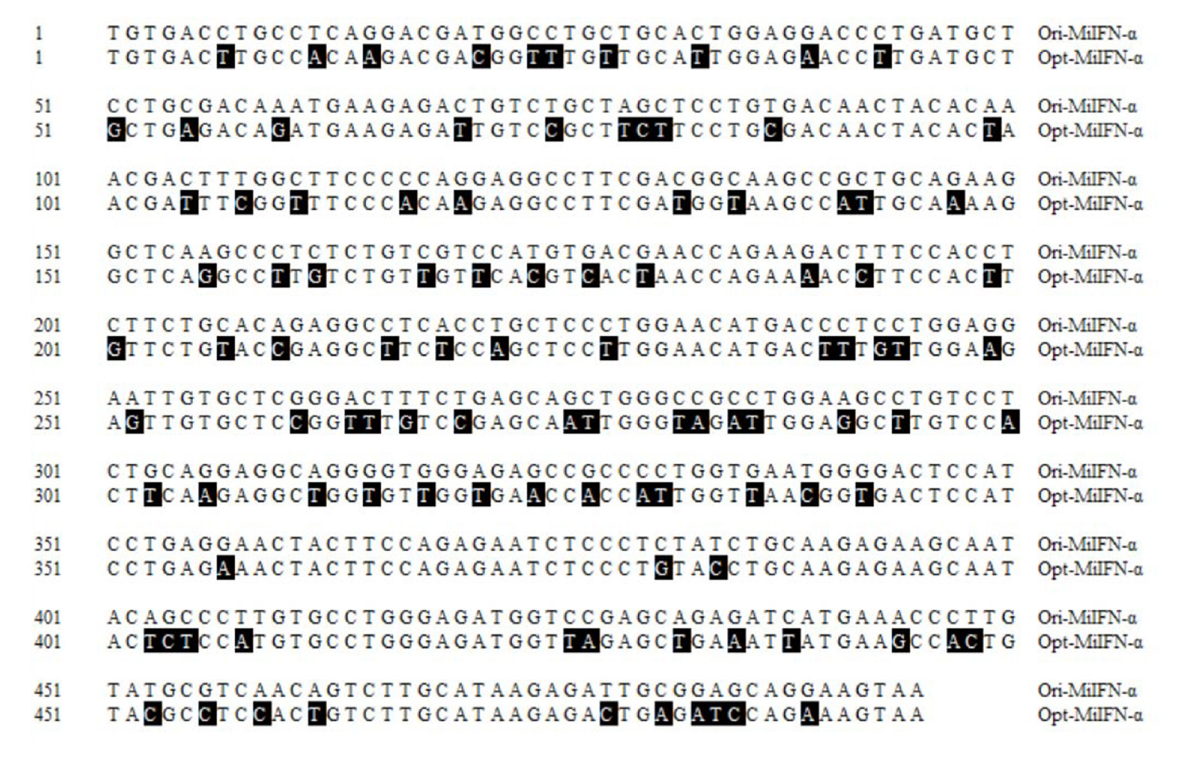
FrontiersinVeterinaryScience